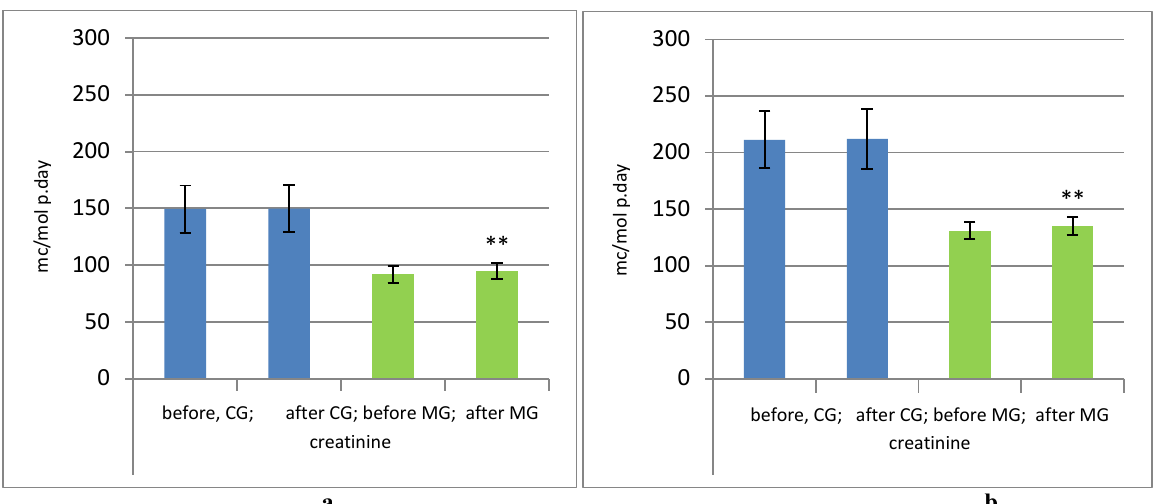
Fig.7. Indicators of bio-chemical monitoring by excretion of creatinine before and after experiment in mixed cluster (of main and comparative groups): a) by bicycle stress test «Vita maxima»; b) by results of control special tests. (** -р≤ 0.01). CG – comparative group, MG – main group.